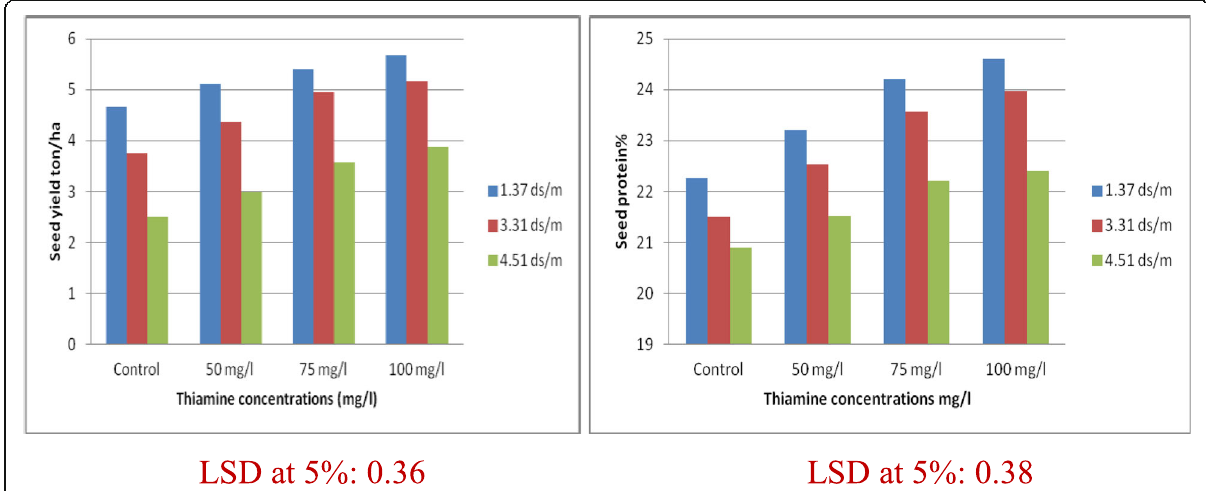
Fig. 9 Effect of the interaction between salinity levels and thiamine levels on seed yield ton/ha and seed protein% (combined analysis of two